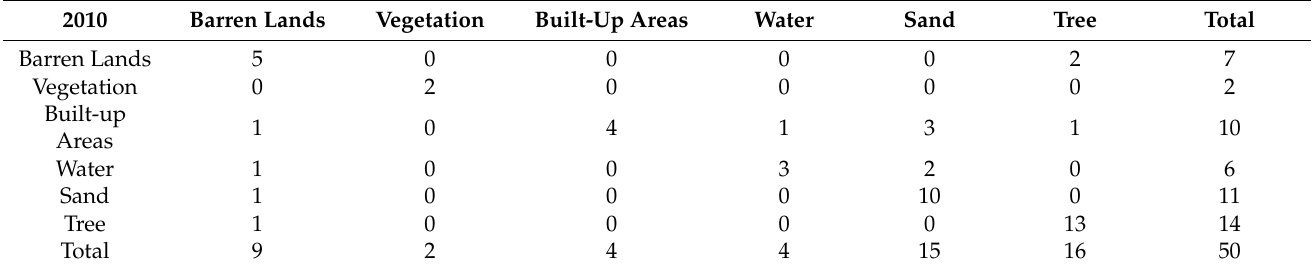
Table 3. Error matrix of land use classification for